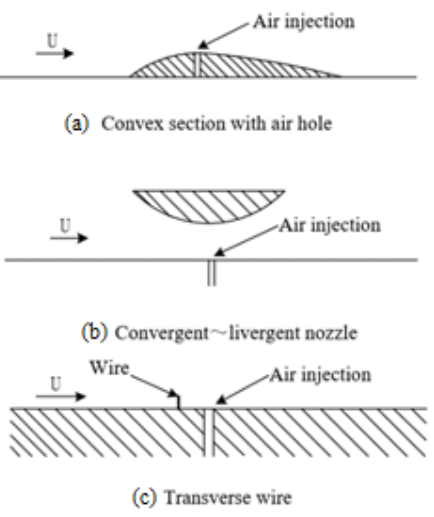
Figure 10. Small bubble generation methods. The following methods are included: ( a ) convex section with air hole; ( b ) convergent – livergent nozzle; ( c ) transverse wire.